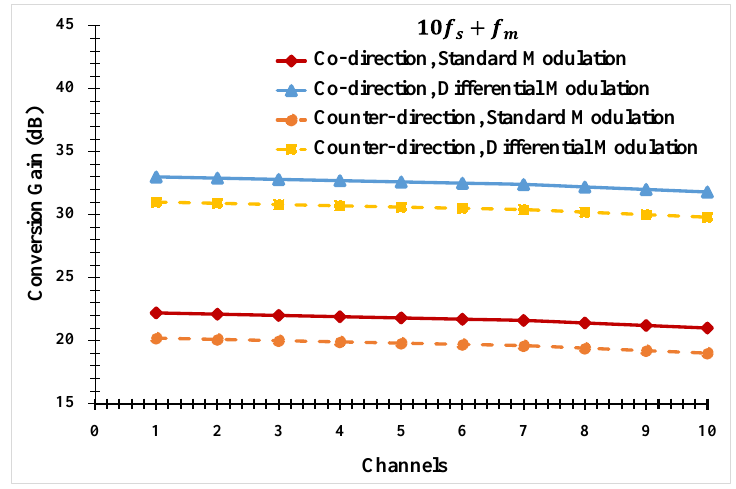
Figure 13. Conversion gains of simultaneous ten up-converted signals at 10 f s + f m related to the tenth harmonic of the sampling signal at the SOA-MZI